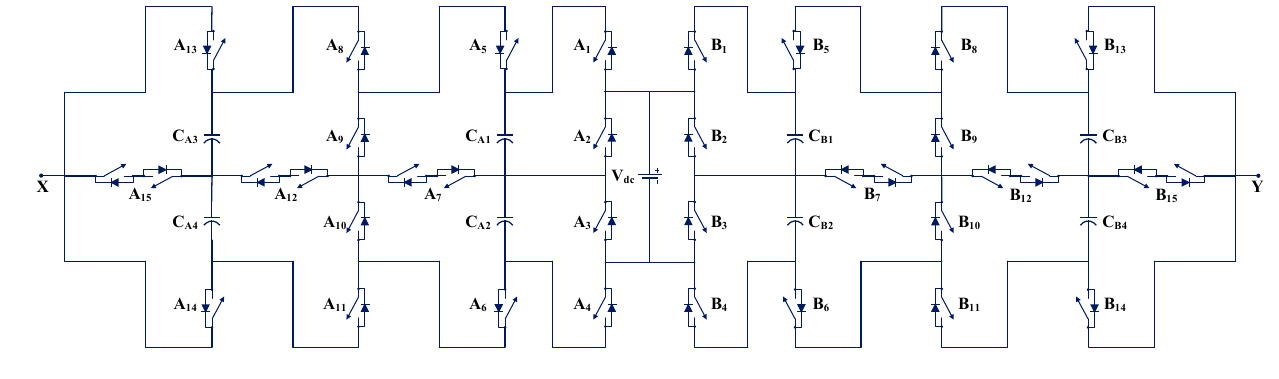
Figure 34. Single-phase fifteen-level FT MLI (TP37) [69].